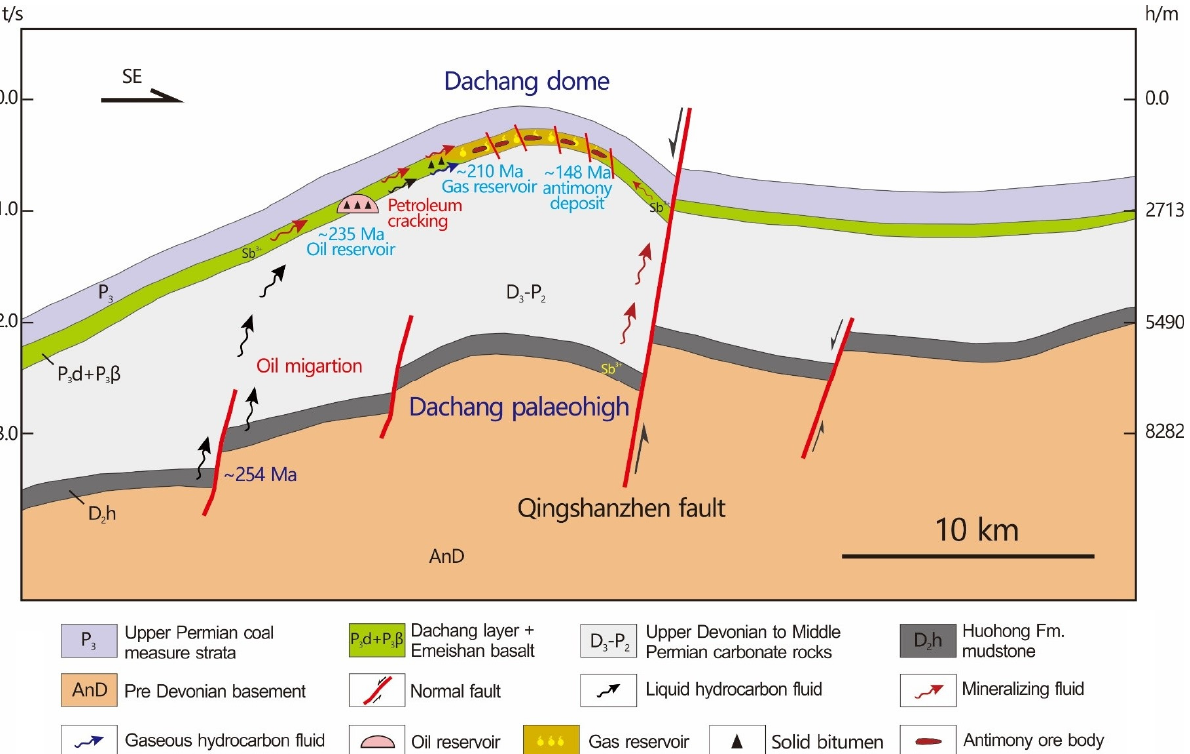
Figure 16. Schematic metallogenic model for the Qinglong antimony deposit, showing the genetic relationship between oil and gas accumulation and antimony mineralization. The stratum, structure, and depth of the figure are based on 2D seismic profile interpretation, which is NW-SE striking and adjacent to the northern area of Figure 2 (modified from [ 38 ]).